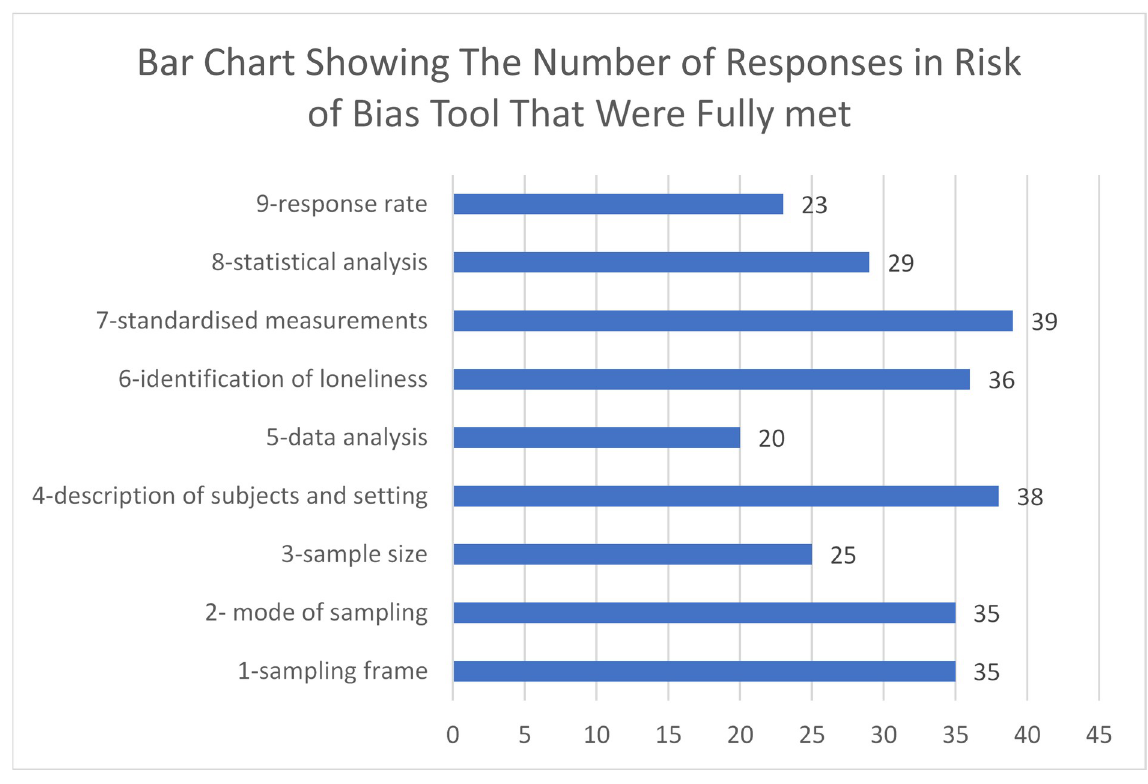
Fig 2. Results of risk of